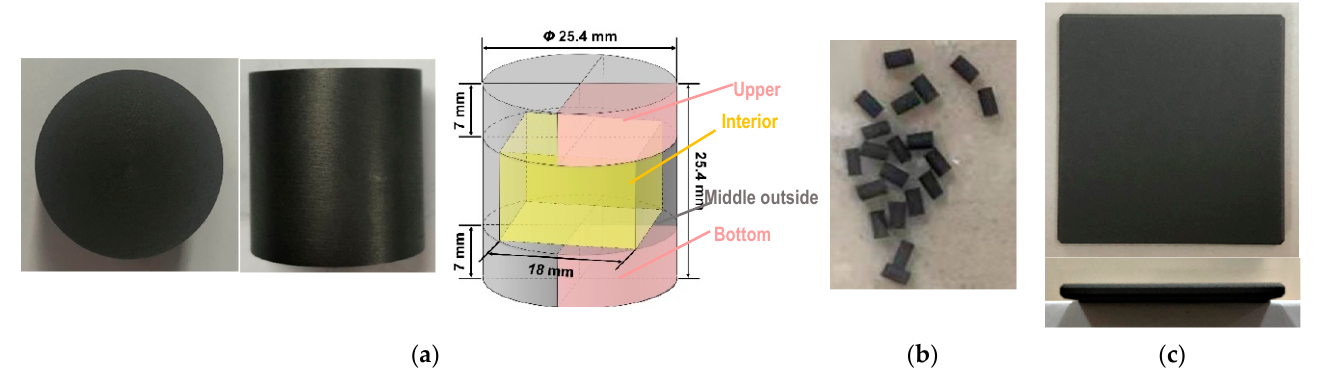
Figure 1. Specimens oxidized in different test facilities: ( a ) large pure graphite specimen; ( b ) small partially SiC-coated graphite specimen; ( c ) fully SiC-coated graphite specimen. Table 1. The main impurities of graphite ET-10 [25]. Table 2. The configurations of different graphite ET-10 specimens and related test